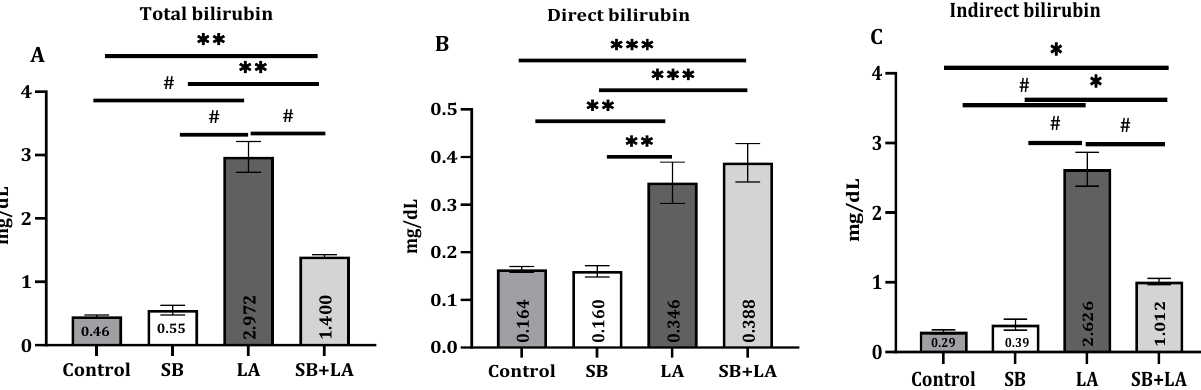
Figure 3. Effect of sodium butyrate, Lead acetate, and their combination on ( A ) total serum bilirubin (mg/dL), ( B ) direct serum bilirubin (g/dL), and ( C ) indirect serum bilirubin (mg/dL) in adult female rats. Mean±SEM, n=10. Control, rats received only drinking water; SB, rats orally received sodium butyrate at 200 mg/kg BW; LA, rats orally received lead acetate at 50 mg/kg BW; SB+LA, rats orally received both sodium butyrate at 200 and lead acetate at 50 mg/kg BW. * P ≤0.05, ** P ≤0.01, ***P≤0.001, # P ≤0.0001